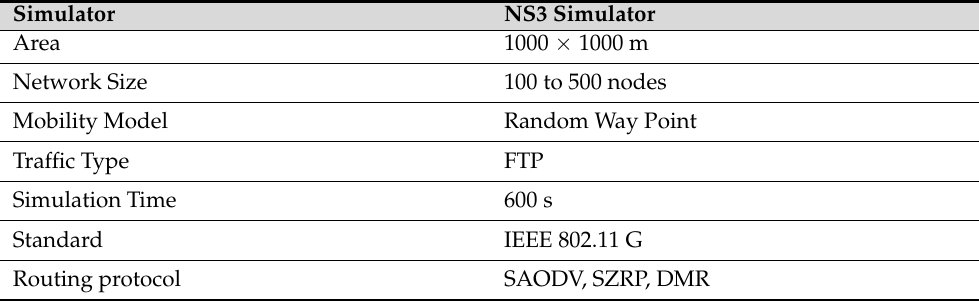
Table 1. SAARICS Simulation — Parameter Table.